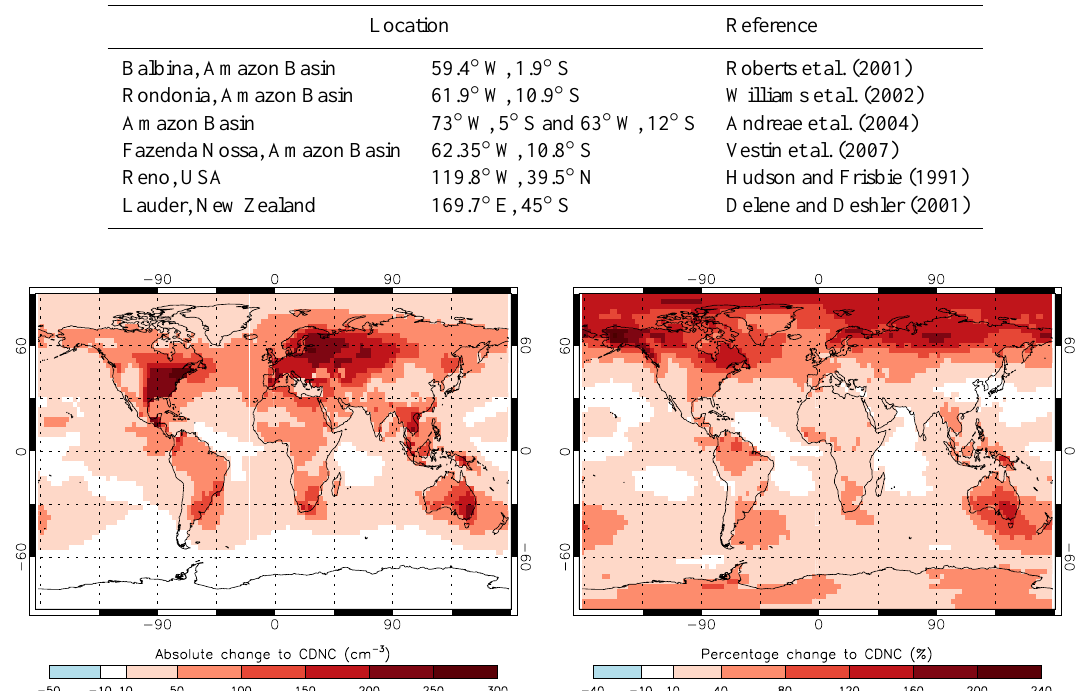
Table 4. Locations included in the subset of CCN observations taken from Spracklen et al. (2011a).